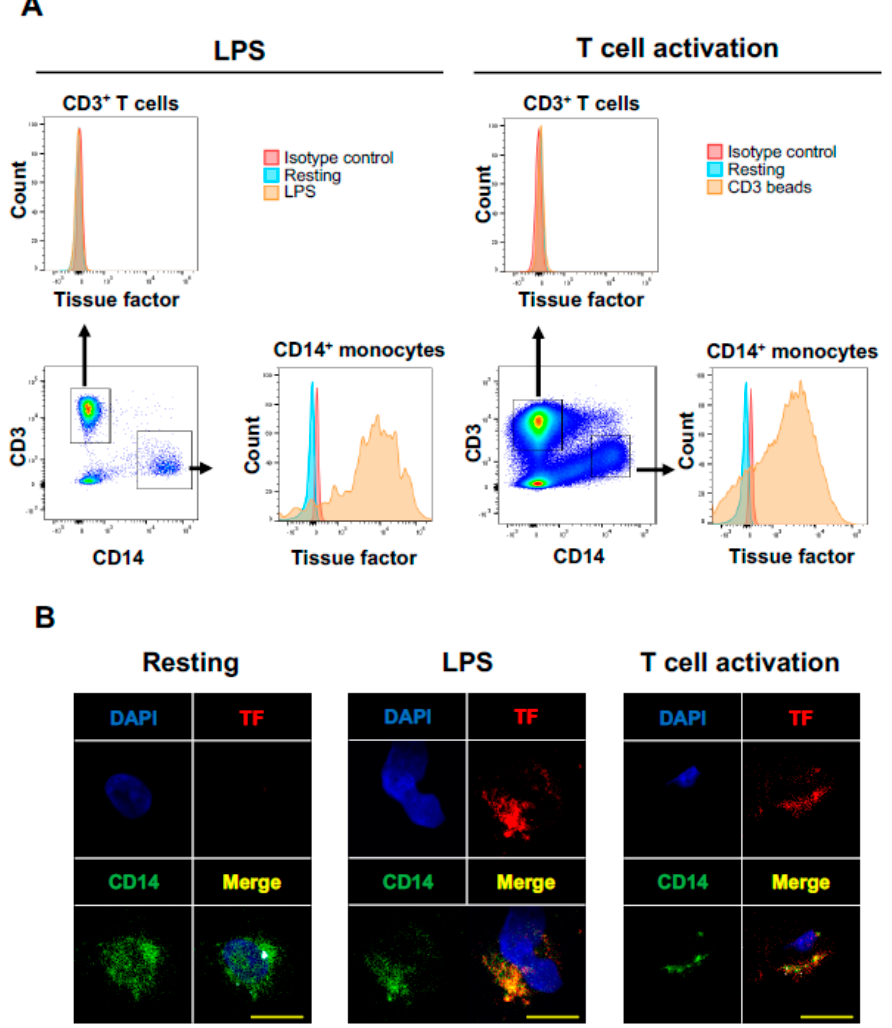
Figure 3. T cell activation induces TF expression on CD14 + monocytes. ( A ) Fresh PBMCs from healthy volunteers were cultured with lipopolysaccharide (LPS) to activate monocytes (left panels) or CD3 / CD28 / CD2 beads to activate CD3 + T cells (right panels). Gating strategy for analysis of CD3 + T cells or CD14 + monocytes is shown at each left lower panel. TF expressions were evaluated for CD3 + T cells and CD14 + monocytes. Representative histograms of TF on each population were shown. ( B ) Representative immunofluorescence images of PBMCs. Fresh PBMCs (left panels), PBMCs cultured with LPS (middle panels) or cultured with CD3 / CD28 / CD2 beads (right panels) were stained with antibodies against CD14 (green) and tissue factor (red). Nuclei were stained with DAPI (blue). Scale bars 10 µ